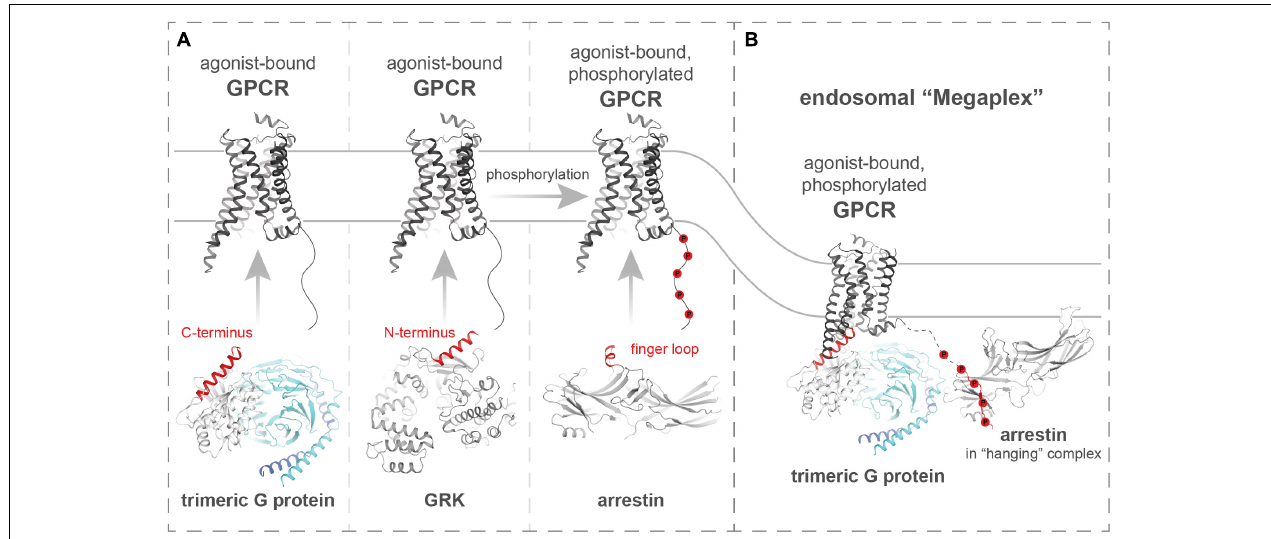
FIGURE 1 | G proteins, GRKs, and arrestins share similar structural features to engage active GPCR folds. (A) Schematic depiction of how active GPCRs (PDB: 3SN6) interact with trimeric G proteins (PDB: 3SN6), GRKs (PDB: 3NYN), and arrestins (PDB: 5DGY), as most prominent mediators and regulators of GPCR signaling. On the cartoon structures of the intracellular effector proteins, helices that interact with active GPCR folds are highlighted in red. (B) Structure of the endosomal complex (PDB: 6NI2) between an active GPCR, a trimeric G protein, and β